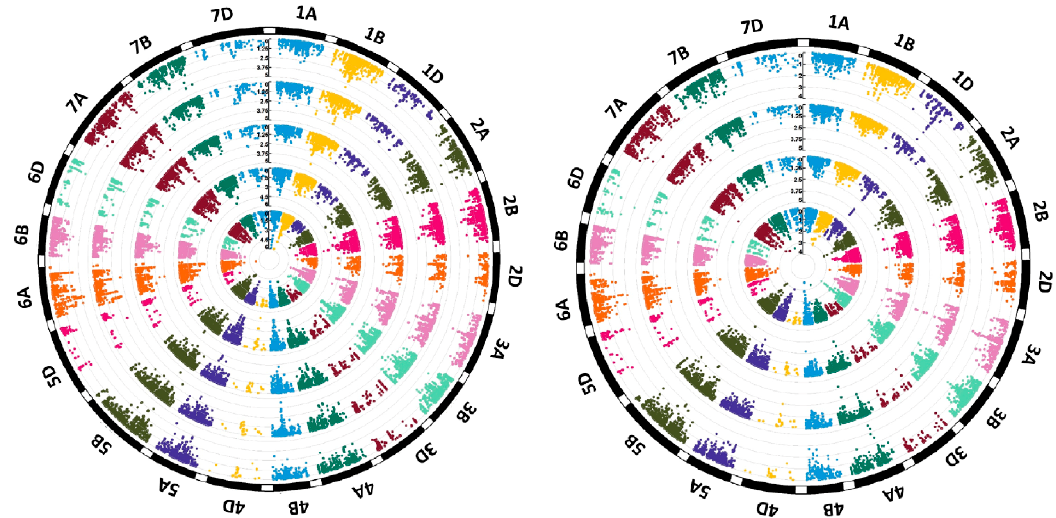
Figure 3. GWAS for root related traits (left circle) and grain yield for 3 years and across years (right circle). From the inside out, root traits correspond to RDW, SW, TRN, SRA, and SL, whereas for GY corresponds to 2016, 2017, 2018 harvesting seasons and the mean across